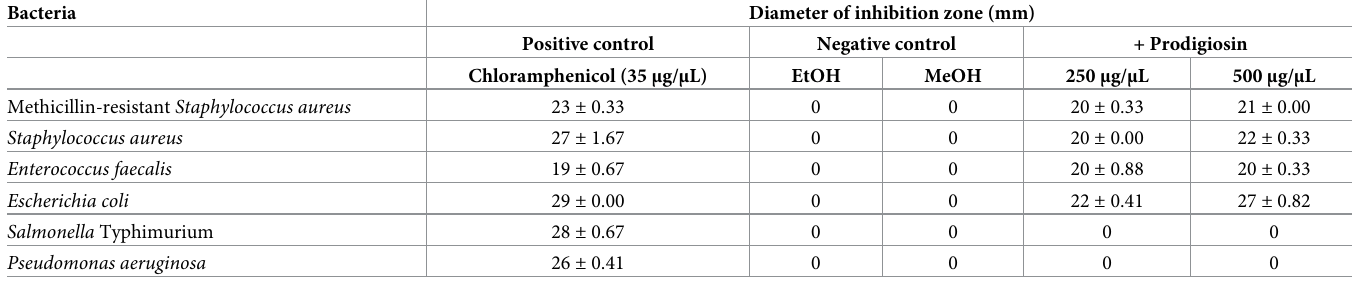
Table 1. Average diameter of inhibition zones of the bacteria tested after 24 hours. Zones of inhibition formed around the discs impregnated with either 250 μ g/ μ L or 500 μ g/ μ Lcrude prodigiosin extract were measured and recorded. Inhibition of bacterial growth was interpreted as a positive inhibition when compared to the correspond- ing inhibition zone from chloramphenicol treatment. Data are presented as averages and standard deviations (n = 3). Bacteria